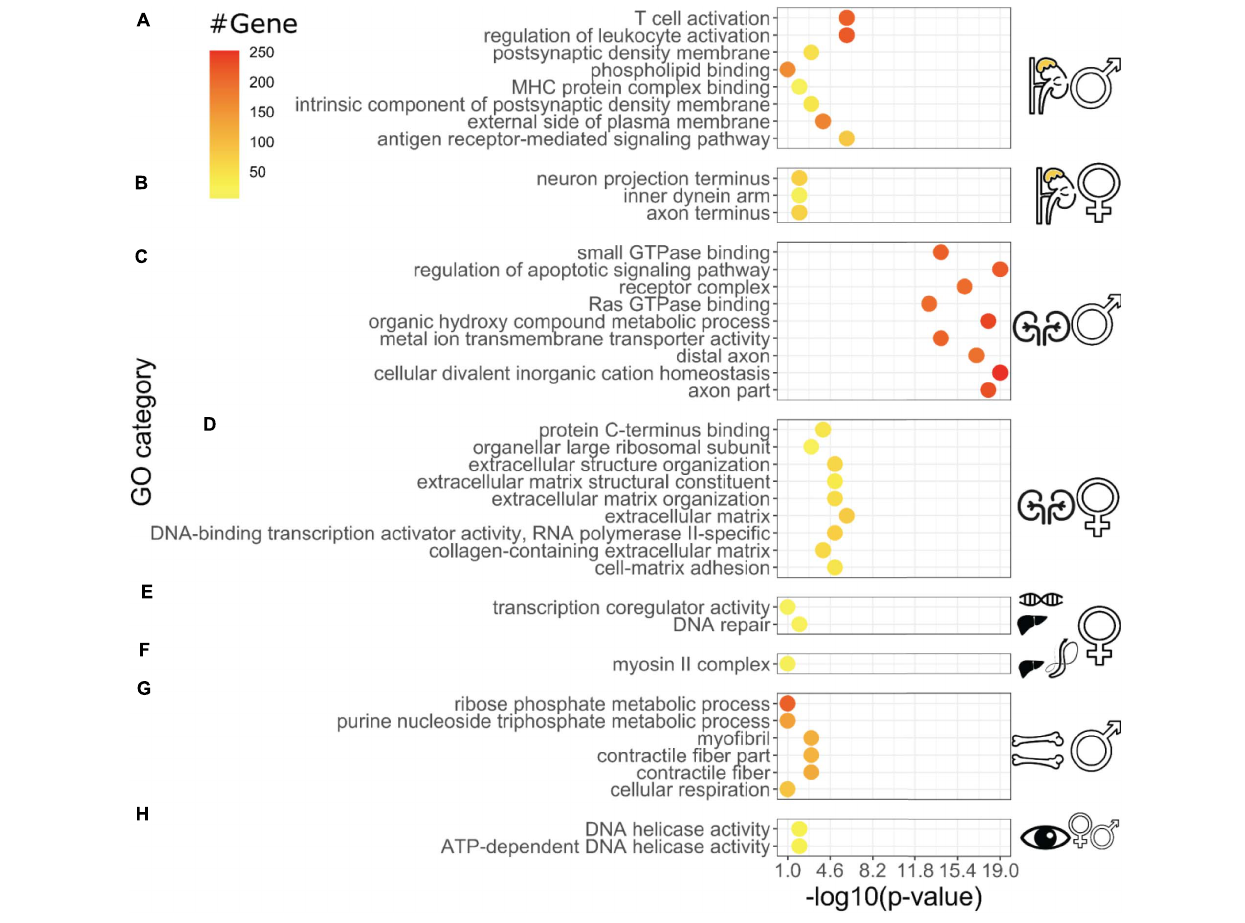
FIGURE 3 | Distinct Gene Ontology enrichments of longevity-correlating genes for individual tissues Gene Ontology categories (Biological Process, Molecular Function, and Cellular Component) with P -values for each tissue. Adrenal gland male (A) , female (B) , kidney male (C) , female (D) , female liver RNA-seq (E) , female liver proteomics (F) , bone femur male (G) , and sex-combined eye tissue (H) . For each dataset, the genes that were most correlated with longevity have been analyzed for clusters of enrichments in the Gene Ontology categories. The display of difference within the same tissues (C,D) and -omics type (E,F) illustrates how longevity might be dysmorphic based on sex and biochemical processes involve (i.e., longevity secretome vs. longevity transcriptome) even within the same experiment (E,F) . The P- values on the X -axis measure the significance of the enrichment categories shown on the Y -axis, and are computed based on, amongst others, the number of genes belonging to the same GO category (“count,” top-right legend), which are color-coded in the data points. More details regarding the enrichment procedure are given in the section “Materials and